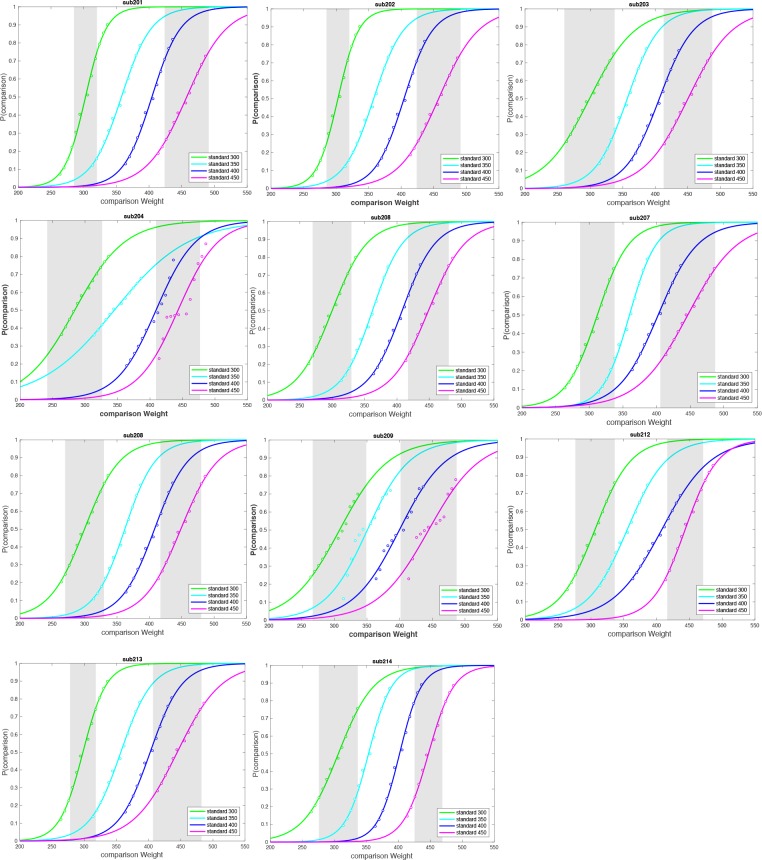
Individual Psychometric functions for the ASD group.